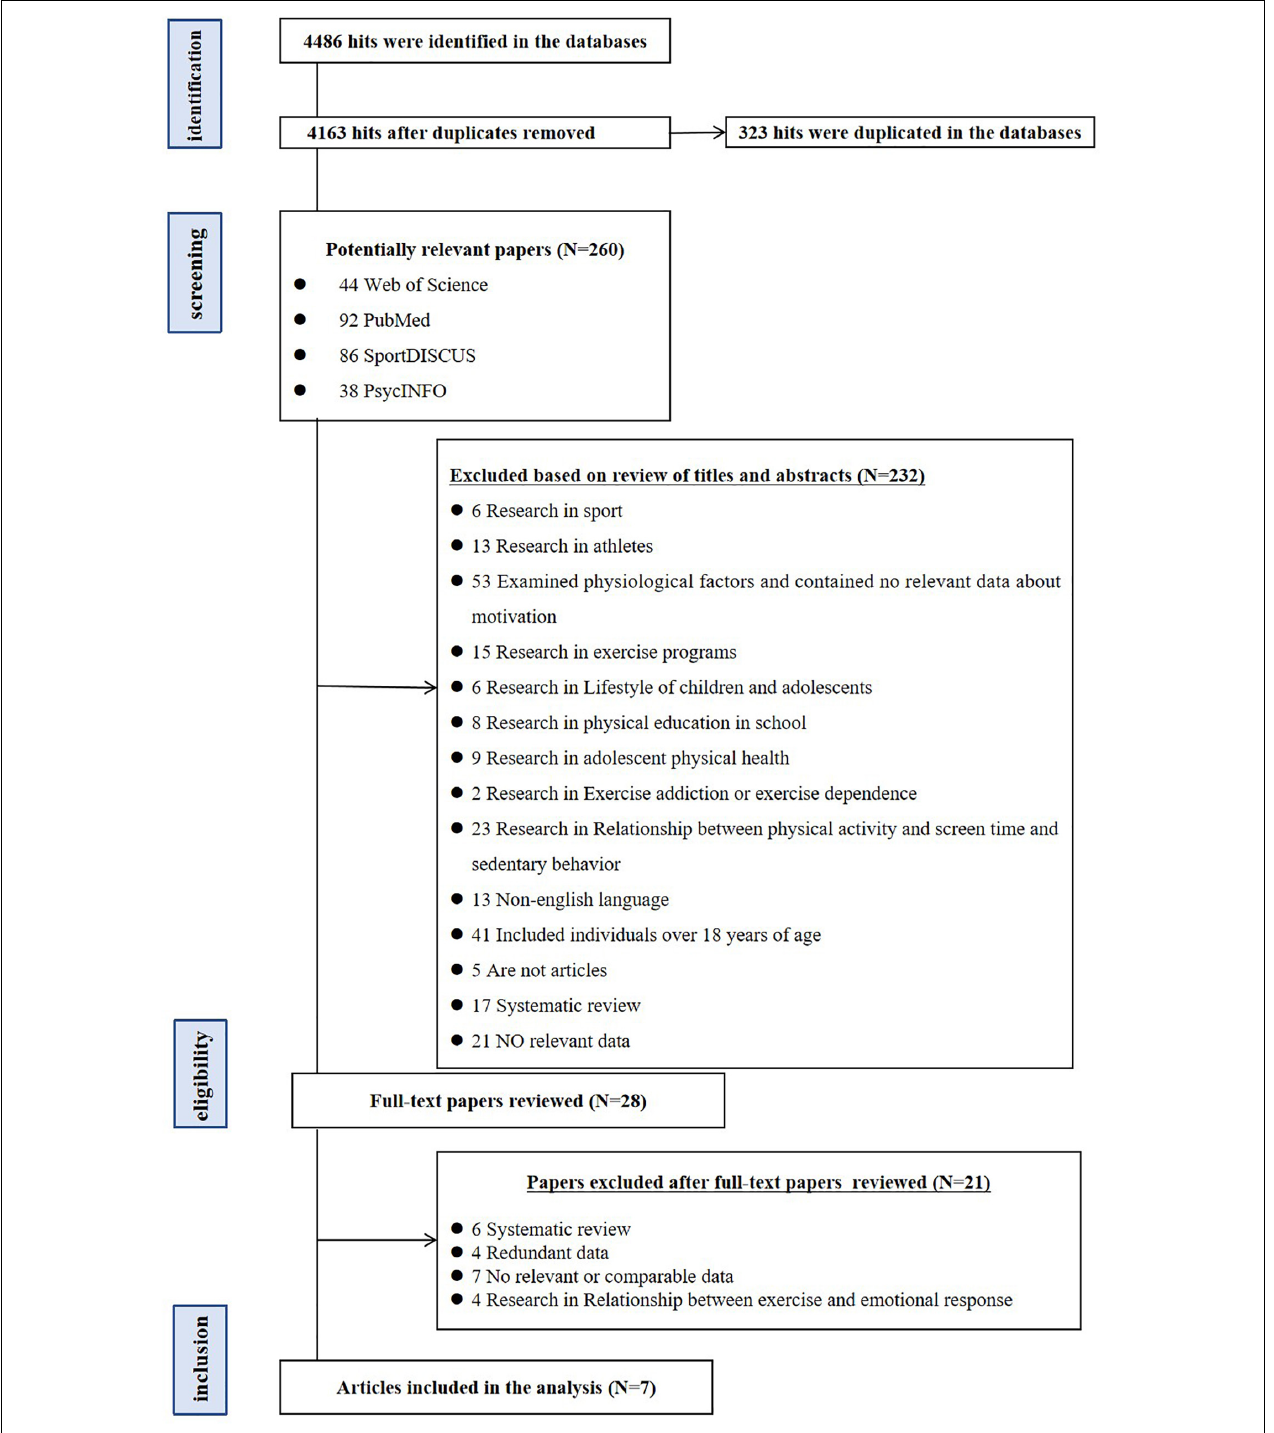
FIGURE 1 | PRISMA